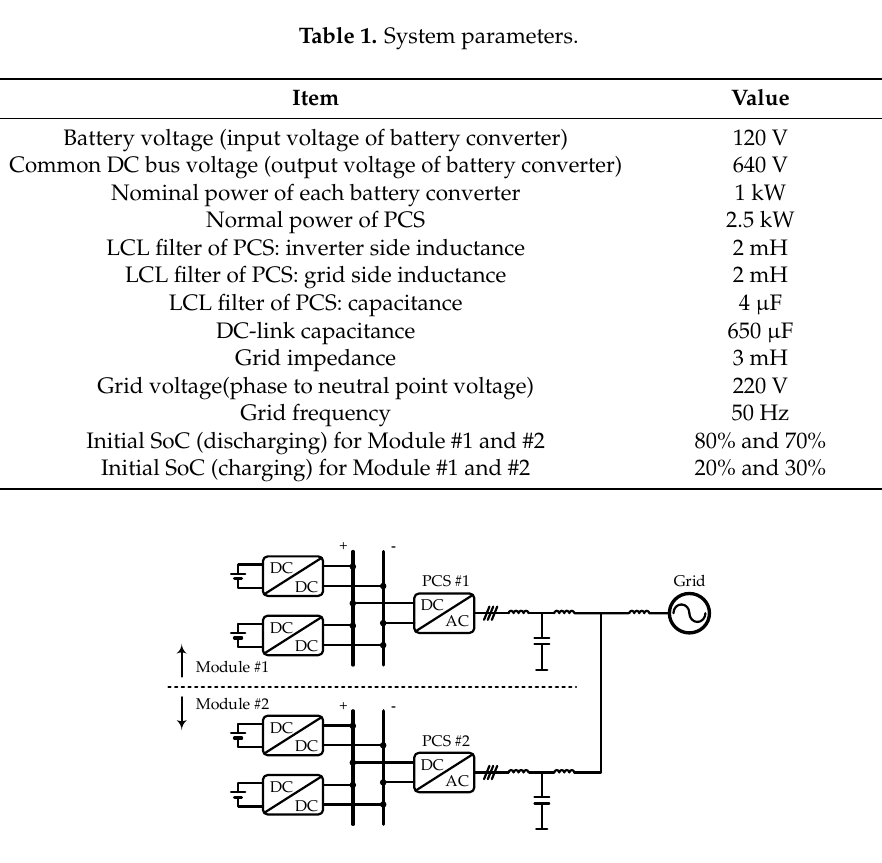
Figure 6. Two-stage BESS test system.